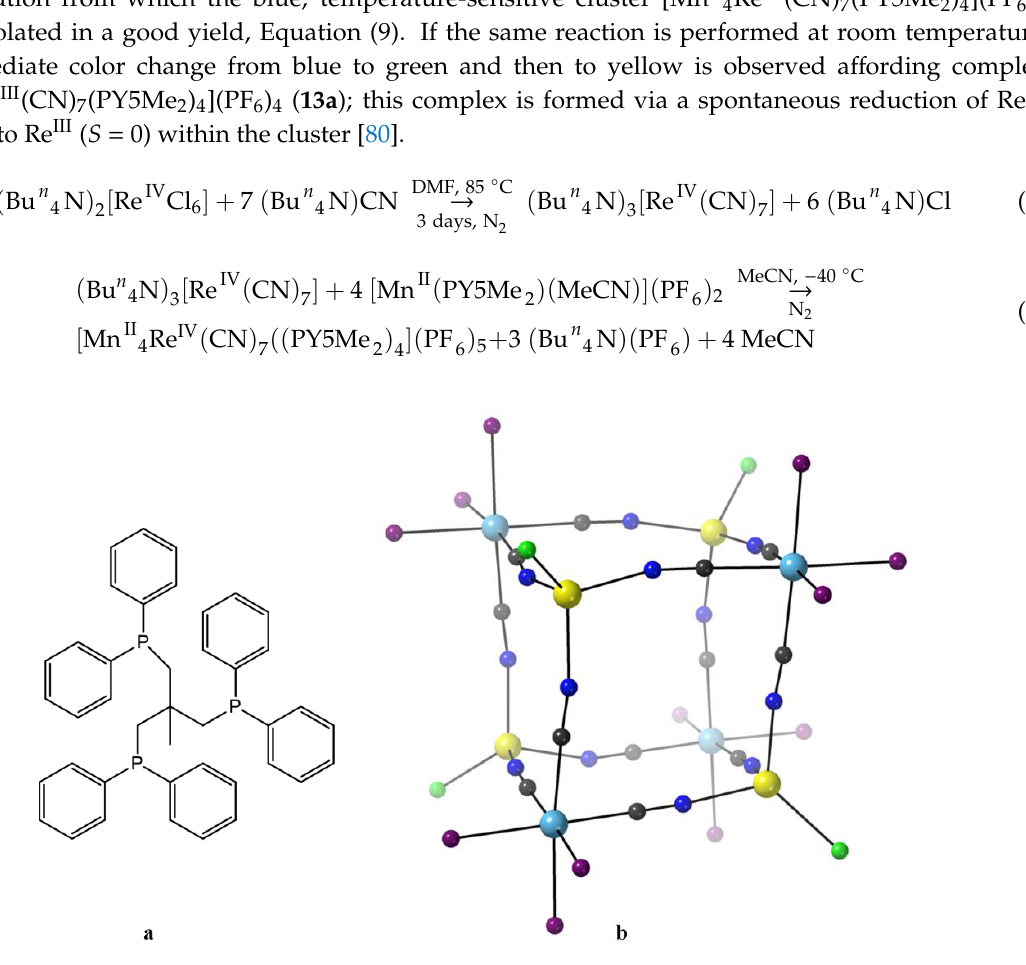
Figure 8. ( a ) The structural formula of triphos. ( b ) An aspect of the molecular structure of the cubic cluster 11 ; only the P atoms of the tridentate chelating phosphine triphos have been drawn. The Re II , Mn II , Cl − , N, C and P atoms / ions are shown with turquoise, yellow, green, blue, gray and mauve colors, respectively. Modified from reference [78].